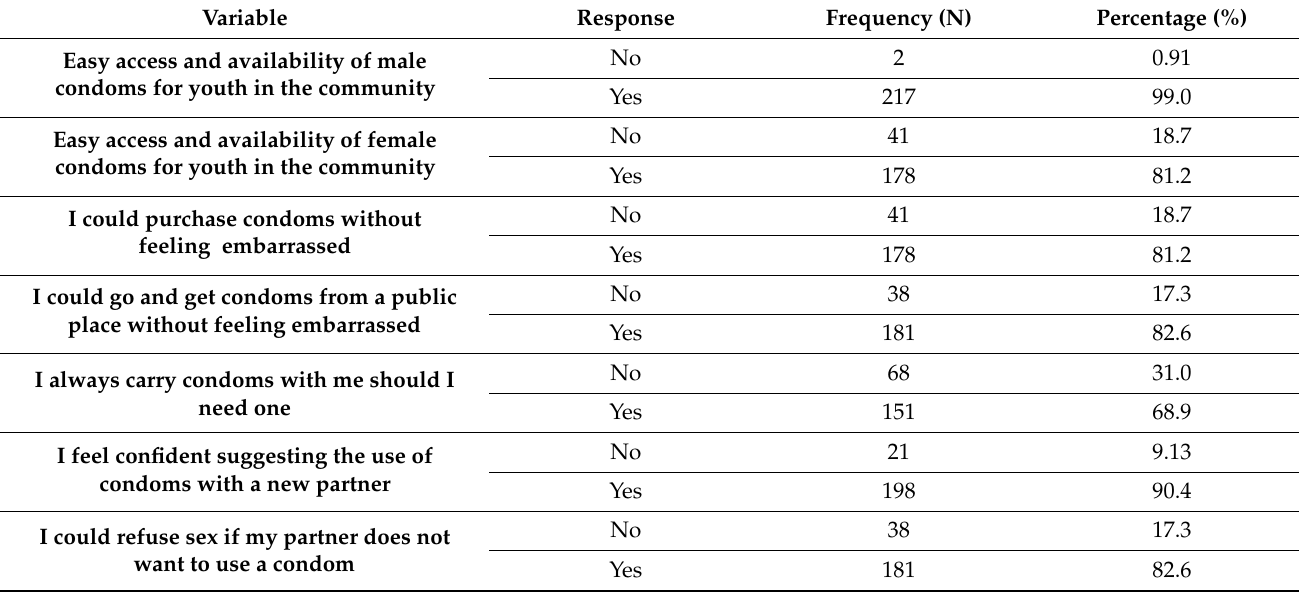
Table 7. Access to condoms (n = 219) by participants.